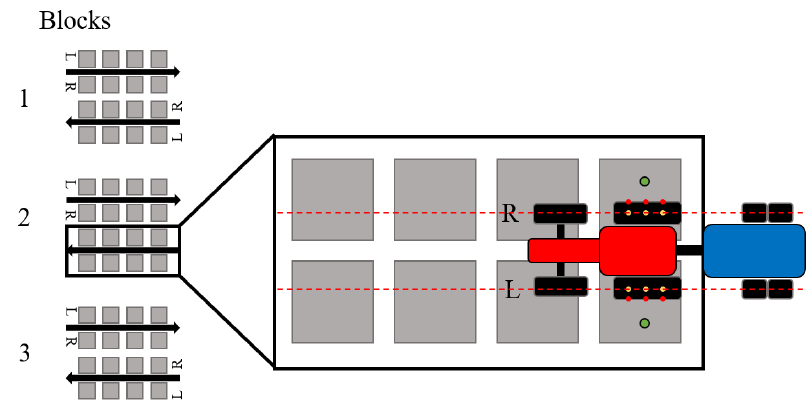
Figure 1. The experiment design included three blocks of 16 square plots with a side length of 2.5 m; four plots of bare soil; one plot per species for the twelve selected species. Each plot was driven over by four wheels of the right side of the combination (R) or the left side (L). The red dotted lines represent the centre of the track. The yellow dots represent the soil cylinders sampled under the middle of the track. The red dots represent the soil cylinders sampled under the edge of the track, at 0.3 m from the middle. The green dots represent the cylinder sampled on each plot for the root trait measurements.